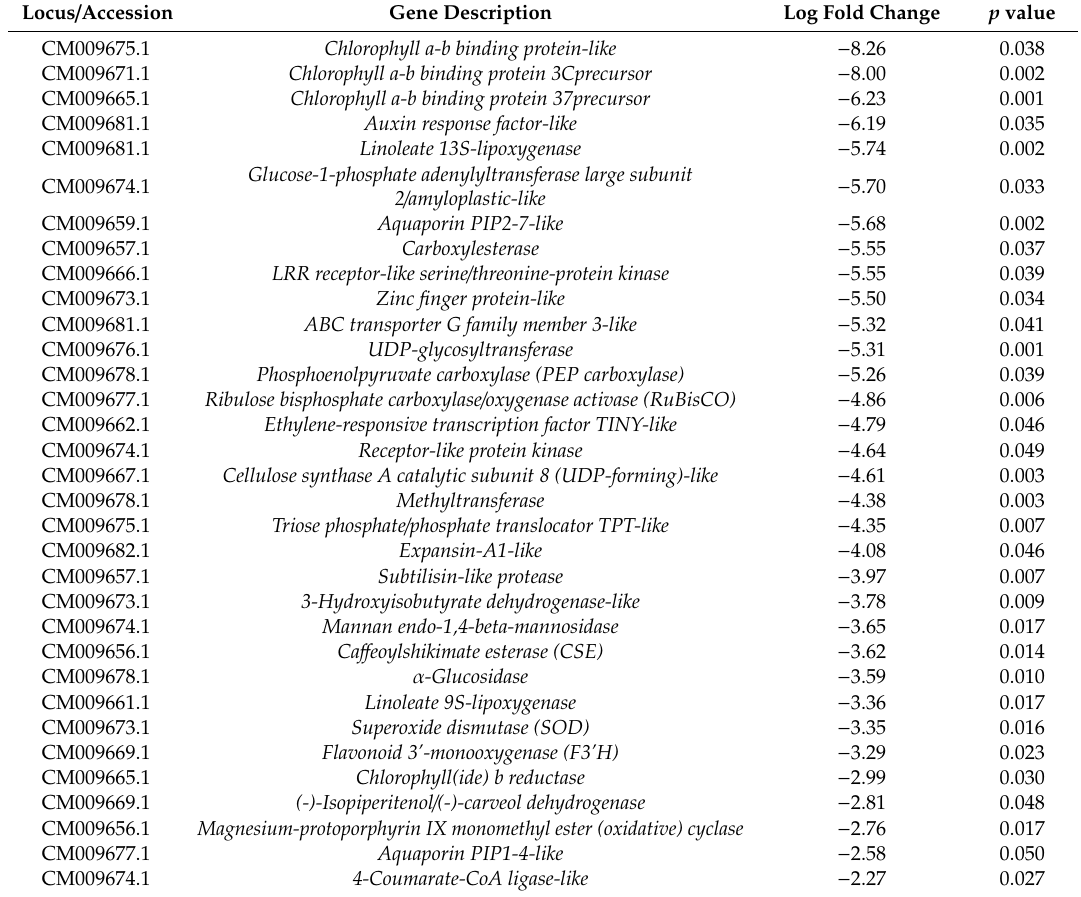
Table 5. List of DEGs in ‘Haegeum’ gold kiwifruit (downregulated) in the comparison of ethylene treated vs.